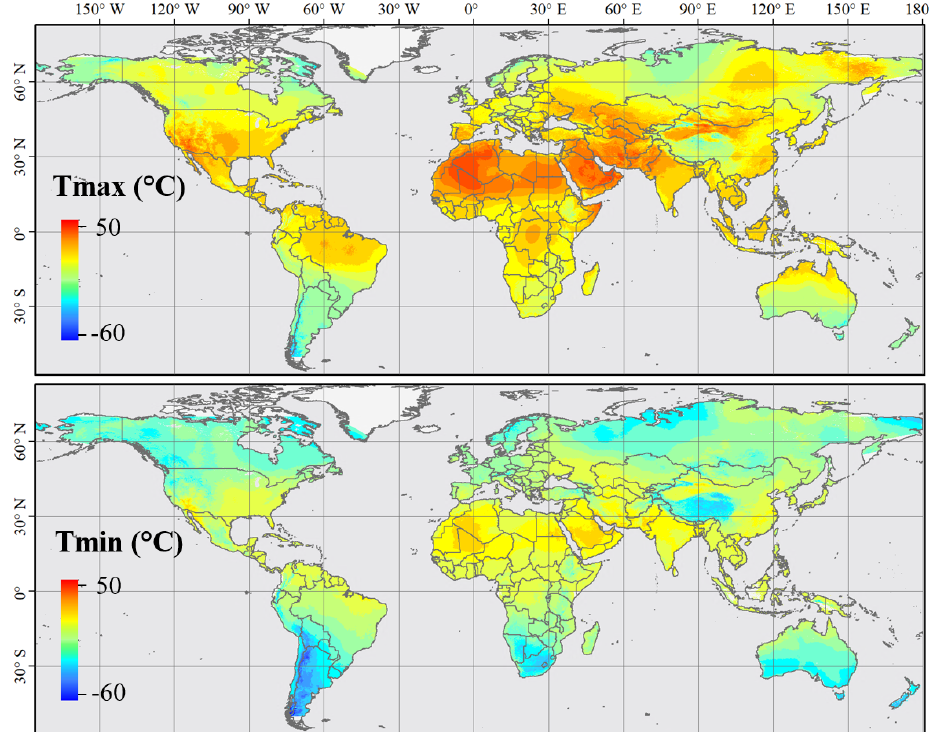
Figure 6. Spatial pattern of estimated T a at the global scale on an example day, day 200, in